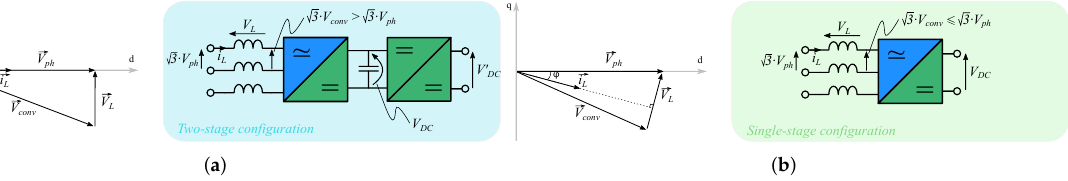
Figure 2. Phasor diagram and converter configuration at ( a ) two-stage and unity PF operation, and, ( b ) single-stage and lower than unity PF